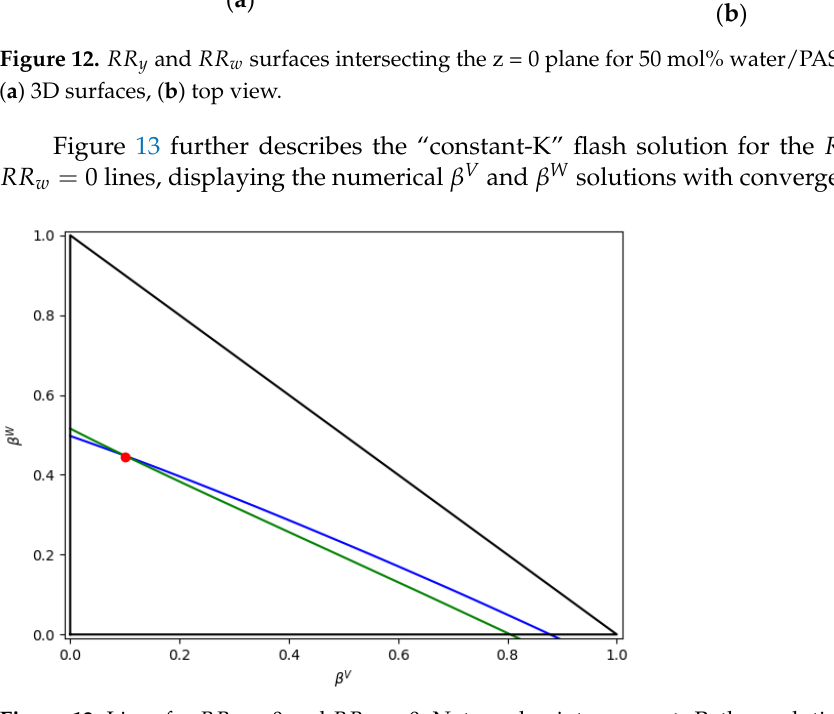
Figure 13. Lines for 𝑅𝑅 𝑦 = 0 and 𝑅𝑅 𝑤 = 0 . Note: red point represents Python solution, the blue line is related to 𝑅𝑅 𝑤 = 0 , and the green line is related to 𝑅𝑅 𝑦 = 0 .